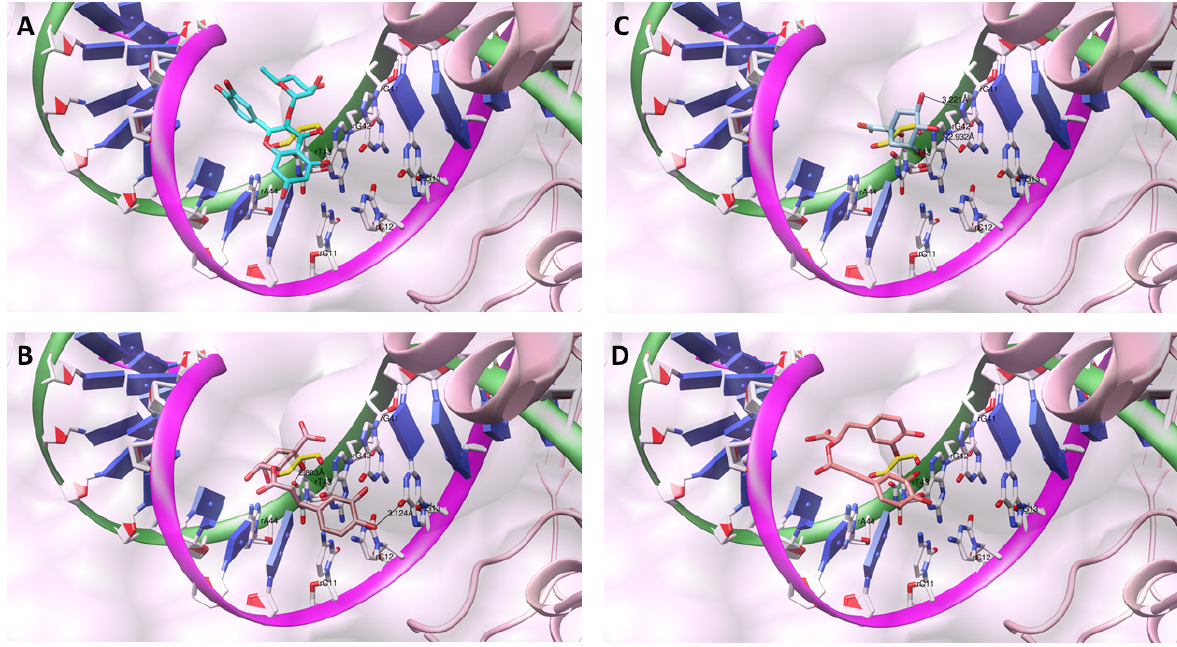
Figure 3. The bioactive conformations of quercitrin ( A ), chlorogenic acid ( B ), quinic acid ( C ), and rosmarinic acid ( D ) within the r DNA binding and cleavage domain of r TopII α . All of the obtained bioactive conformations were superimposed to MDA illustrated in yellow. The sense strand is depicted in green, and the antisense strand is colored purple. The nucleotides of interest are depicted in white, whereas the remaining ones are displayed by blue nucleotides objects. For the clarity of presentation, the C -terminal domain of r TopII α , nesting the targeted compounds, is illustrated by a pink sphere, whereas the non-targeted C -terminal domain is denoted by pink ribbons.